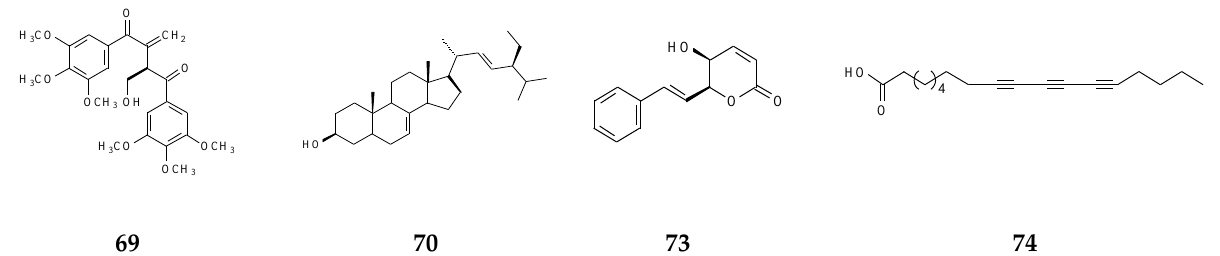
Figure 4. The phytochemical compounds isolated from species of Polyalthia with cytotoxic/anti-tumor activity (1–12, 15, 21,